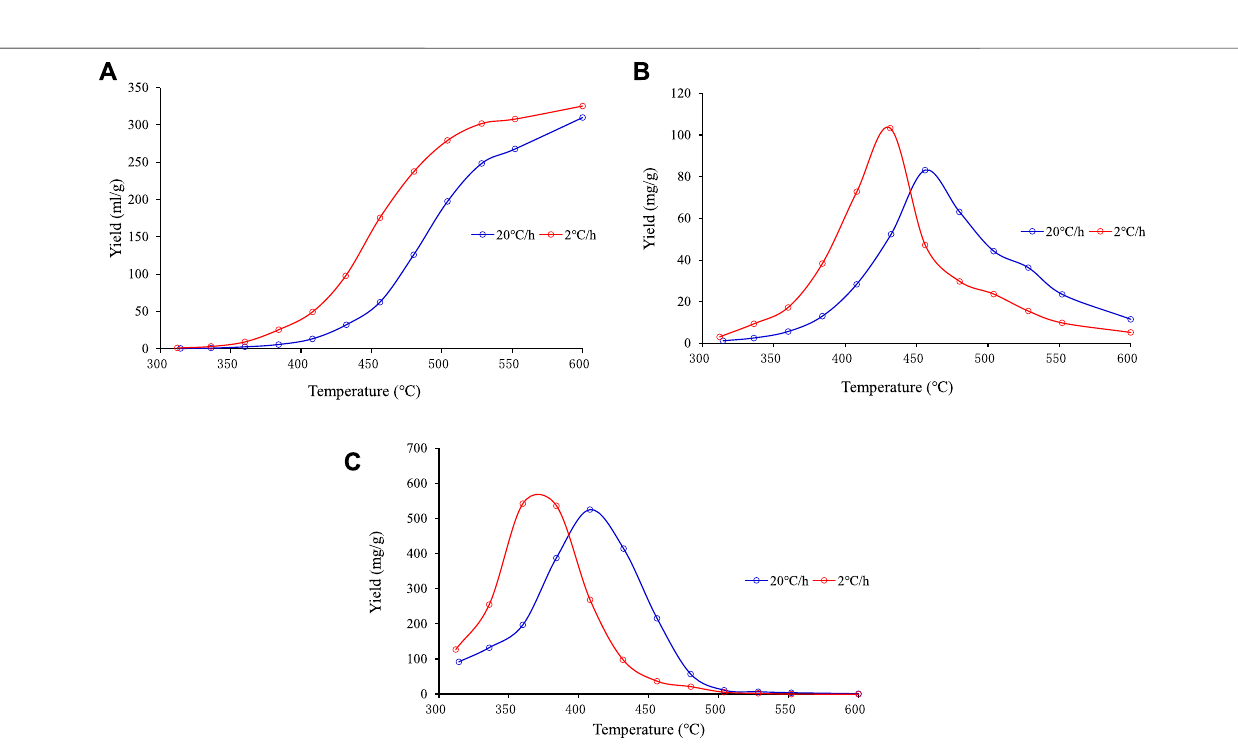
Frontiers in Earth Science |